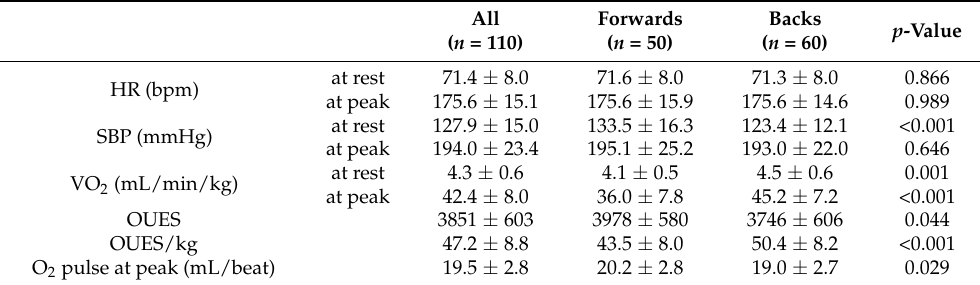
Table 2. Cardiopulmonary exercise testing parameters of young Japanese rugby athletes.